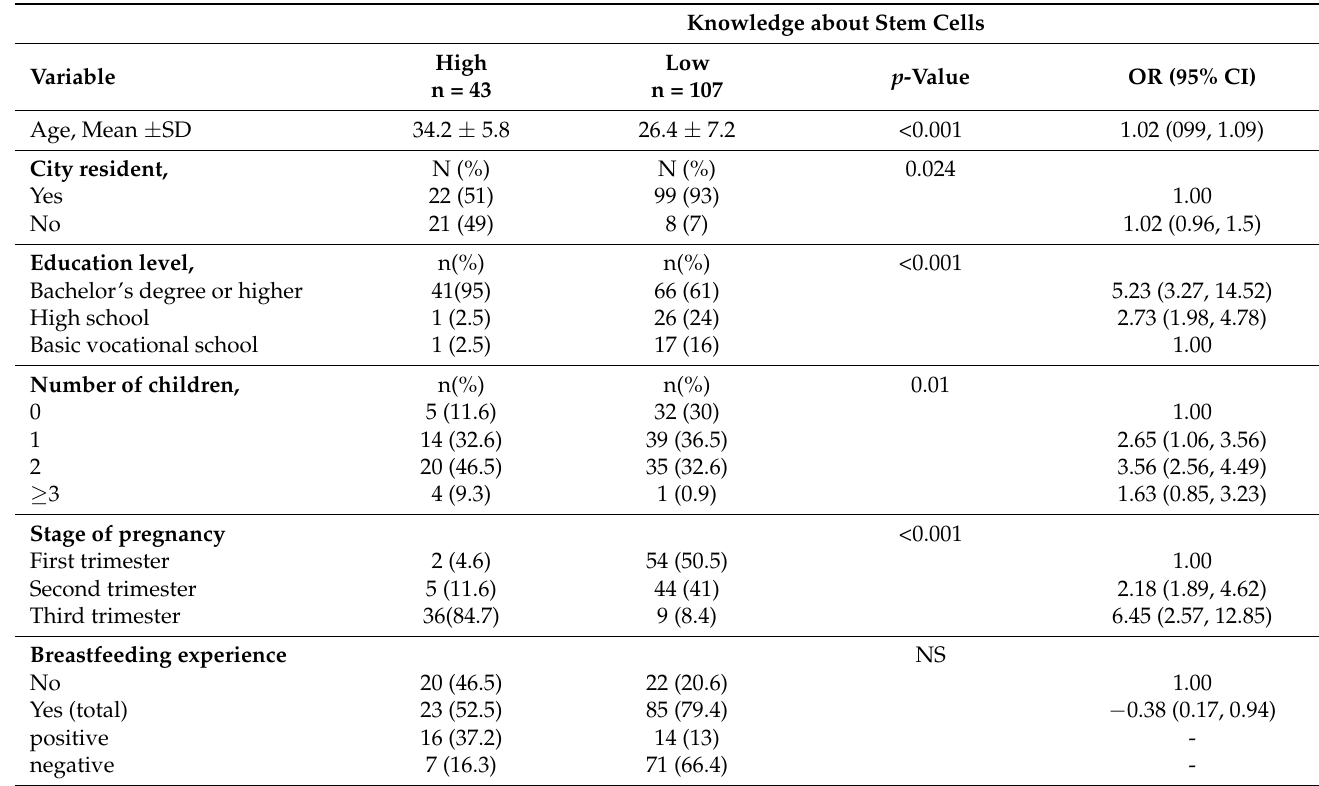
Table 3. Multiple logistic regression analysis of socio-demographic and obstetric characteristics of respondents and their general knowledge regarding stem cells (n =